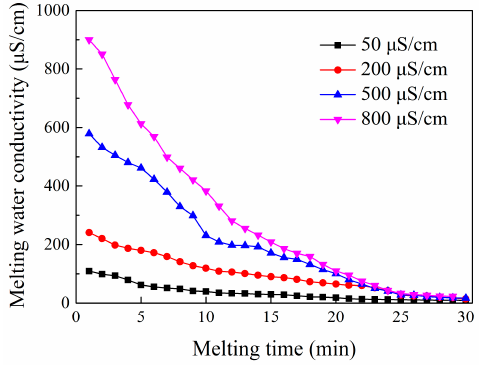
Figure 6. Variation of the melting water conductivity of ice layer.